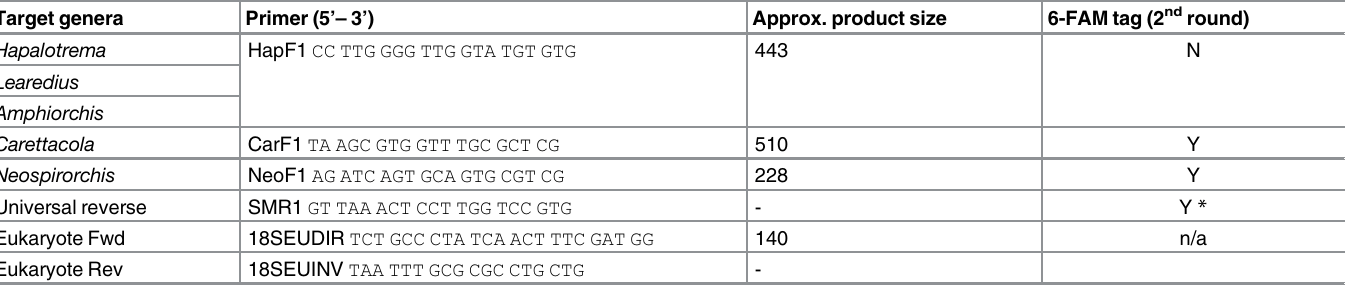
Table 1. Primers designed to target the 28S regions of spirorchiid genera, and 18S Eukaryote primers used as controls to validate DNA quality where negative results for spirorchiids were obtained. Target